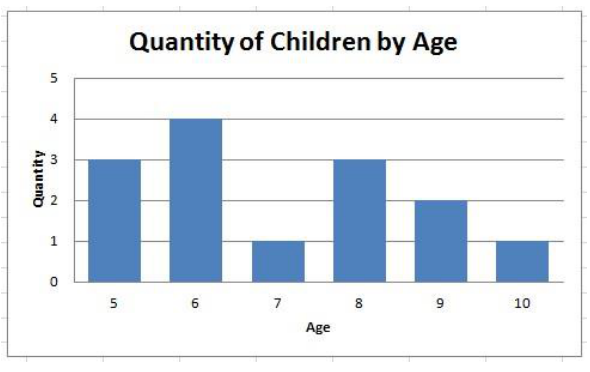
Graphic 1. Quantity of Children by Age